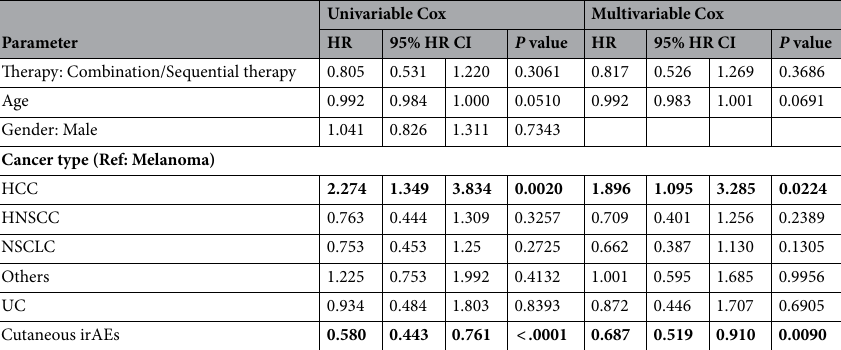
Table 2. Cox regression model to evaluate the influencing factors on survival of these patients. Others included all the cancer types listed in the Table 1 other than melanoma, hepatocellular carcinoma, head and neck squamous cell carcinoma, non-small cell lung cancer, and urothelial carcinoma. CI confidence interval, HCC hepatocellular carcinoma, HNSCC head and neck squamous cell carcinoma, HR harzard ratio, irAEs immune-related adverse events, NSCLC non-small cell lung cancer, UC urothelial carcinoma. Significant values are in